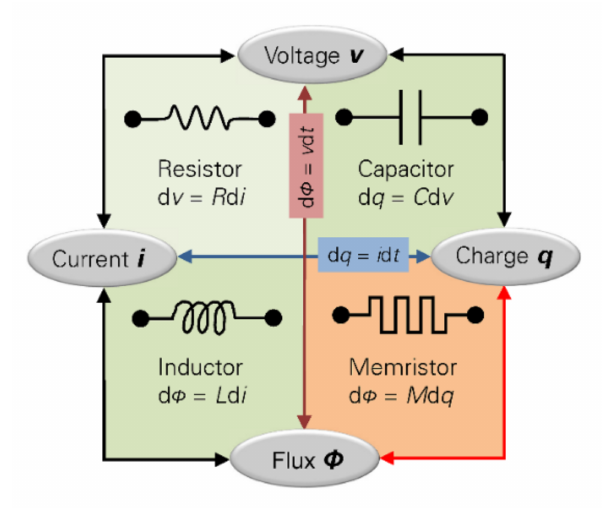
Figure 1. Electronic components